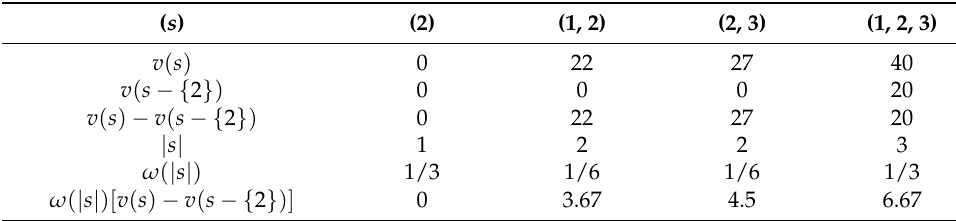
Table 2. Profit distribution table of enterprise 2.